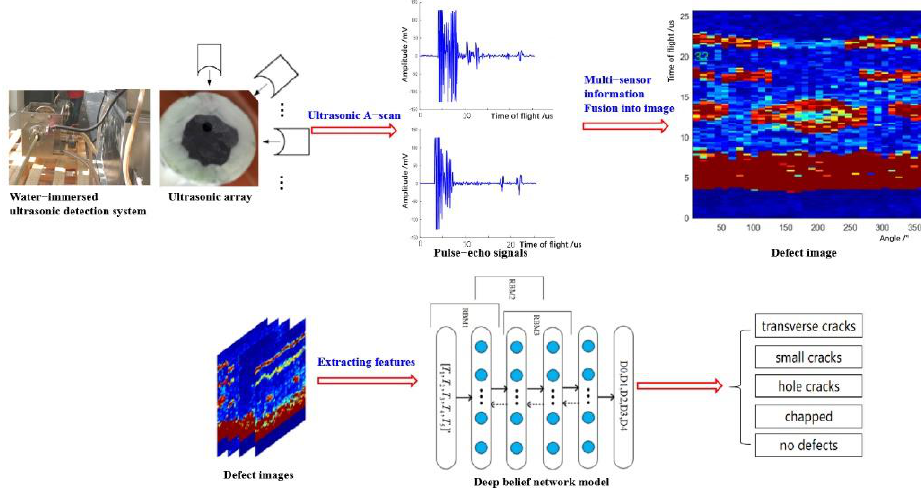
Figure 3. Flow chart of defect detection and identification.